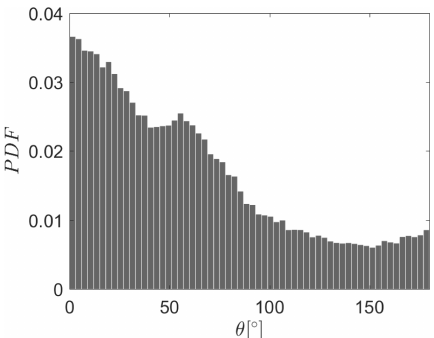
Table 1. Summary of measurement data used from ASIT and FINO1.